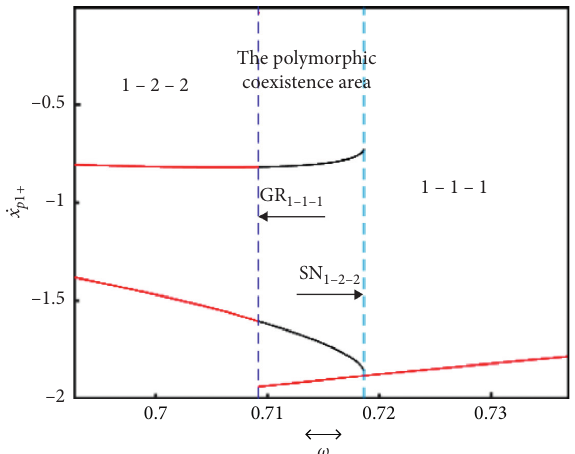
Figure 6: Bidirectional single-parameter bifurcation diagram of � 0 . b 1